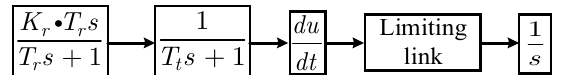
Figure 2. Reheat steam turbine model considering Generation Rate Constrains (GRC).